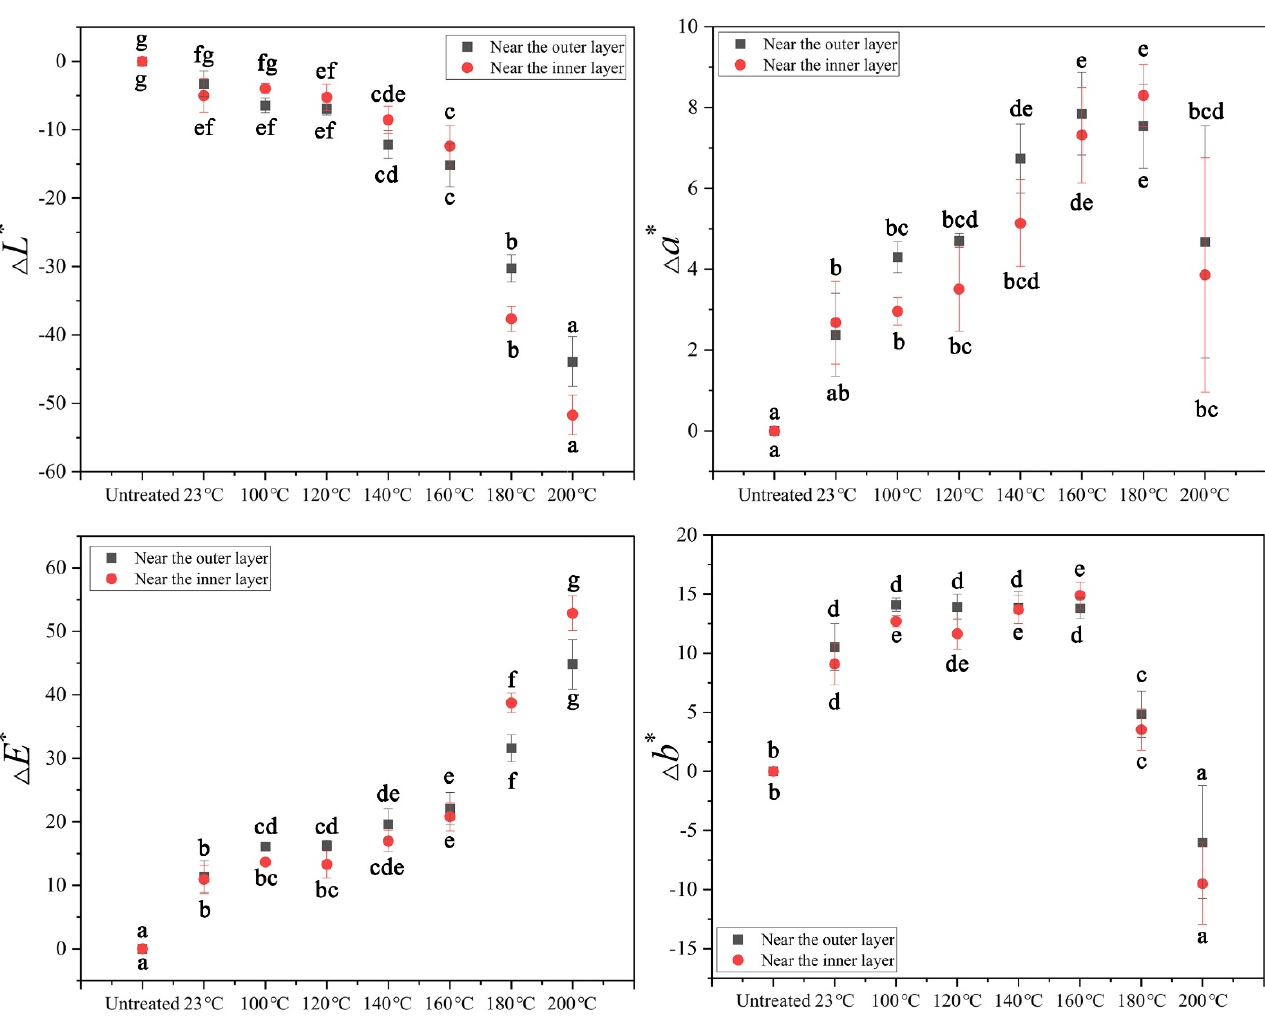
Figure 2. The variation in bamboo color after tung oil treatment at different temperatures. (* Note: Mean values followed by the same superscript letters (a, b, c, d, e, f or g) in the same column are not significantly different at <0.05. Values in parentheses are standard deviations. Outer: the surface near the outer layer of bamboo. Inner: the surface near the inner layer of bamboo.).